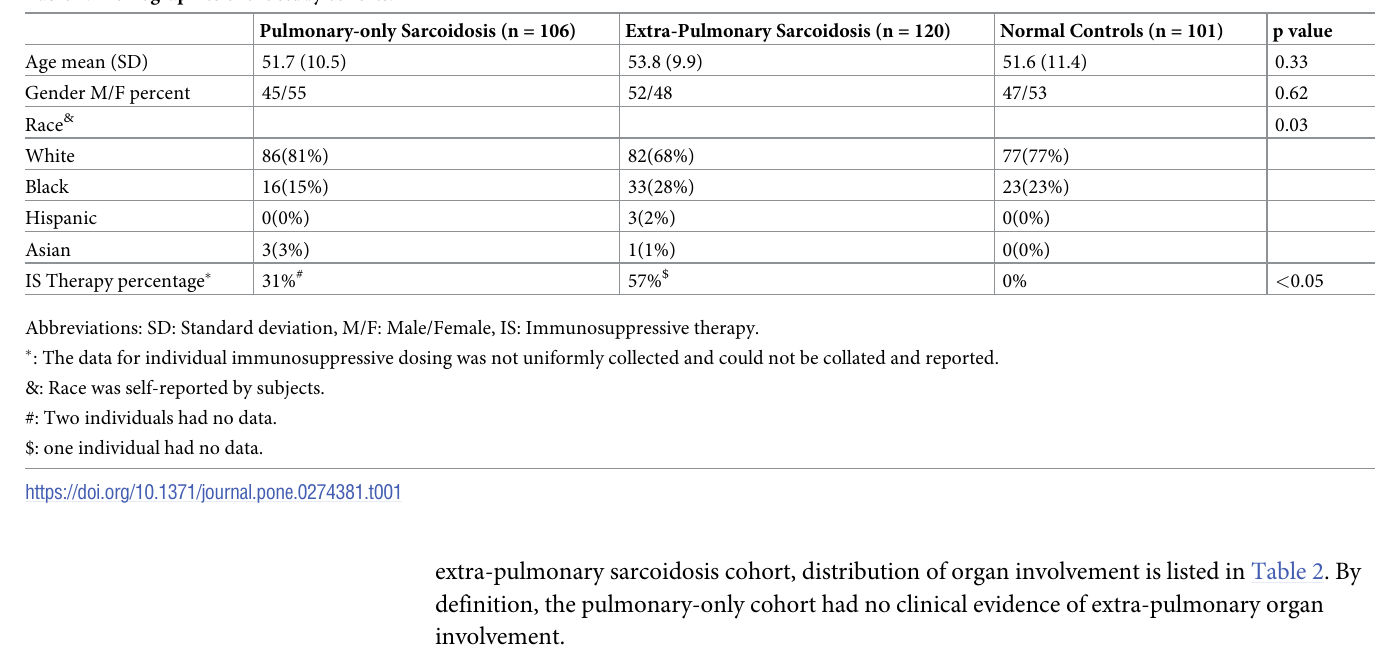
extra-pulmonary sarcoidosis cohort, distribution of organ involvement is listed in Table 2. By definition, the pulmonary-only cohort had no clinical evidence of extra-pulmonary organ involvement.